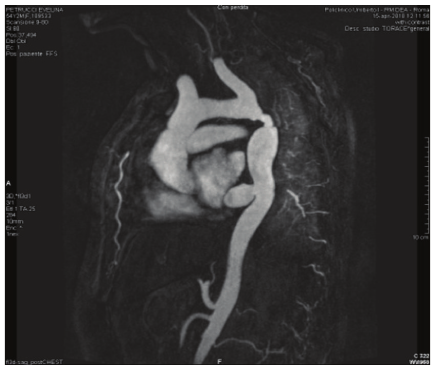
Figure 1: MR, recurrent aortic coarctation.